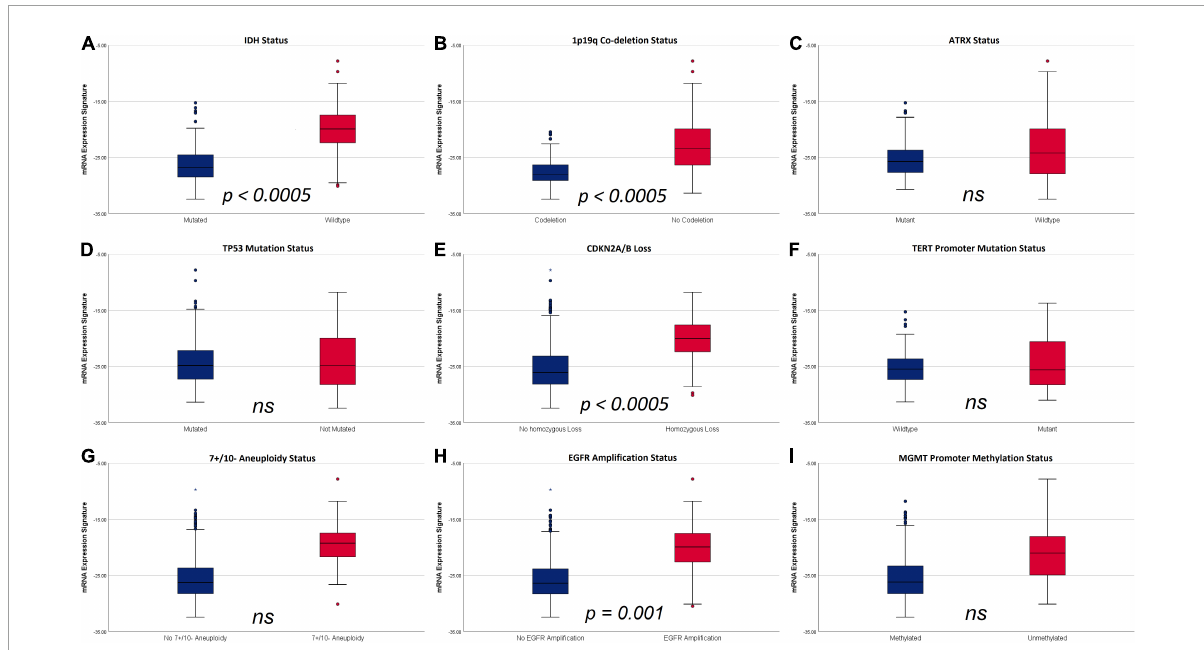
FIGURE3 Boxplots of mRNA expression signature distribution according to distinct molecular glioma markers. (A) IDH status: IDH wild type tumors showed a significantly higher mRNA expression signature compared to IDH mutant tumors. (B) 1p19q codeletion status: tumors without codeletion showed a significantly higher mRNA expression signature compared to codeleted tumors. (C) ATRX status: No significant differences were observed according to ATRX status. (D) TP53 mutation status: No significant differences were observed according to TP53 mutation status. (E) Homozygous CDKN2A/B loss: tumors with homozygous CDKN2A/B loss had significantly higher mRNA expression signatures compared to tumors without homozygous CDKN2A/B loss. (F) TERT mutation status: No significant differences were observed according to TERT mutation status. (G) 7 + /10- aneuploidy status: No significant differences were observed according to 7 + /10- aneuploidy status. (H) EGFR amplification: mRNA expression signature were significantly higher in tumors with EGFR amplification. (I) MGMT promoter methylation status: No significant differences in mRNA expression signature were observed according to MGMT promoter methylation